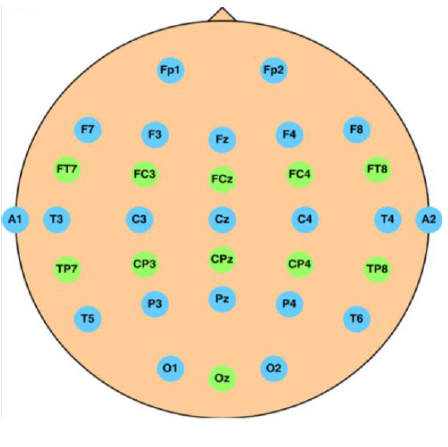
Figure 6. The layout of the electrodes in the EEG cap used for the experiments in